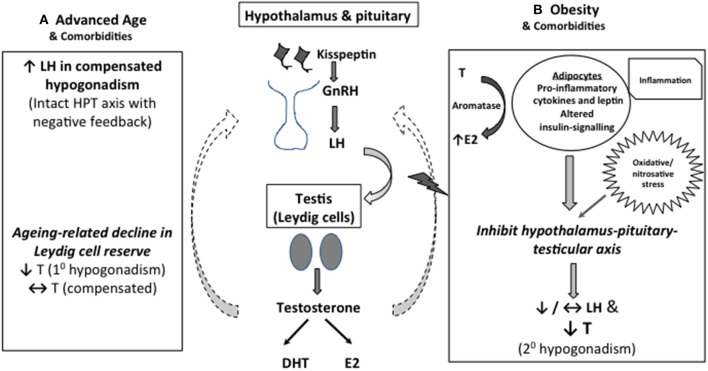
Mechanistic explanation for low serum T in middle-aged and older men. (A) As Leydig cell reserve decline with aging, compensatory rise in luteinising hormone (LH) occurs to maintain circulating testosterone (T) concentrations (compensated hypogonadism). In more advanced state, elevated LH can no longer overcome the diminished testicular function, leading to overtly low T levels (primary hypogonadism). (B) Obesity is the predominant cause of functional suppression of hypothalamic-pituitary-testicular (HPT) axis in middle-aged and older men, manifesting as failure of LH response to low T (secondary hypogonadism). Multimorbidity is also associated with both primary and secondary hypogonadism, albeit to a lesser degree. Excess adiposity has been linked to altered insulin signaling, oxidative stress and increased pro-inflammatory cytokines and leptin levels, which act in concert to suppress the central HPT axis. Adipose tissues also express aromatase which convert testosterone to estradiol, especially in the inflammed state, exerting inhibitory effects on the HPT axis.